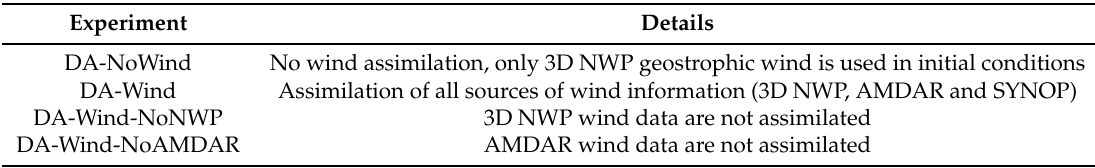
Table 1. Data assimilation